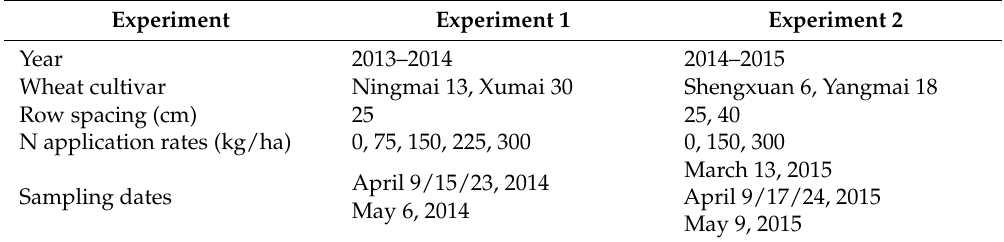
Table 4. Experimental design and sampling dates for the two growing